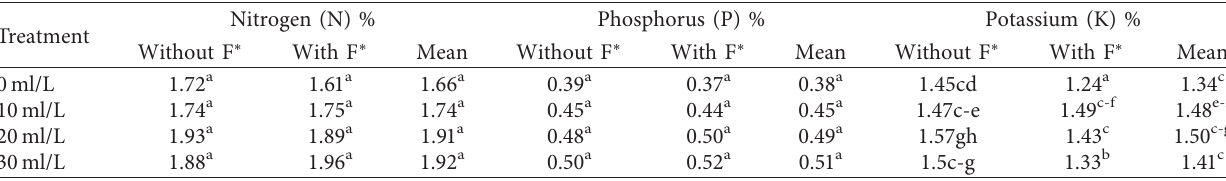
Table 2: Interaction of biopesticide dosage and Fusarium